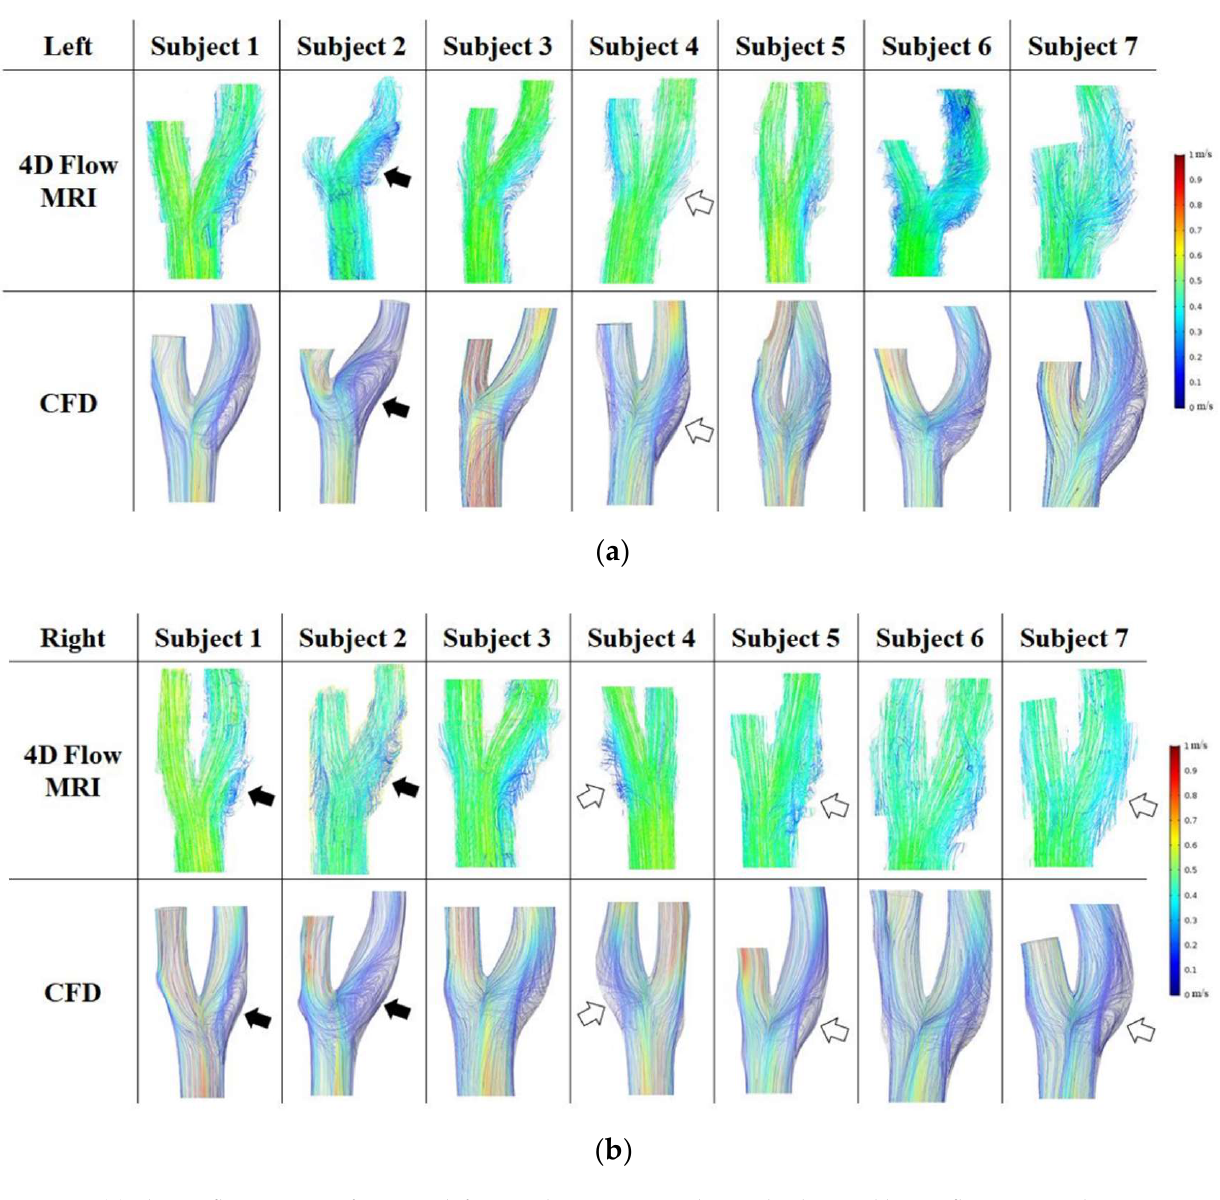
Figure 6. ( a ) The 3D flow patterns for seven left carotid arteries at peak systole observed by 4D flow MRI with ITK-SNAP ( first row ) and CFD ( second row ). ( b ) The 3D flow patterns for seven right carotid arteries at peak systole observed by 4D flow MRI with ITK-SNAP ( first row ) and CFD ( second row ).